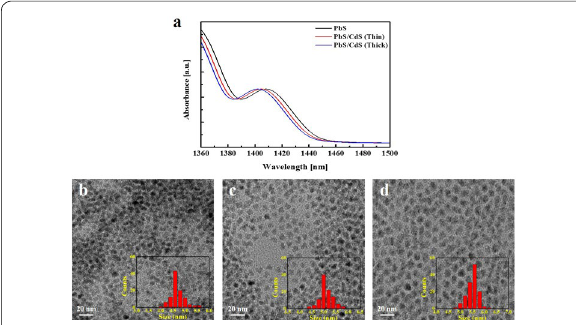
Fig. 1 The characteristics of the synthesized QDs. a Absorption spectra of PbS, PbS/CdS (thin shell), and PbS/CdS (thick shell) QDs in toluene. TEM image and corresponding size histogram of the b PbS QDs, c PbS/CdS (thin shell), and d PbS/CdS (thick shell) QDs